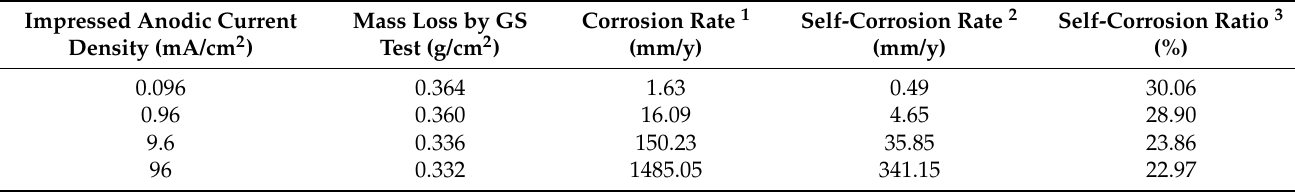
Table 5. Measured parameters of the one-year corrosion-accelerated specimen as a function of impressed anodic current den- sity.